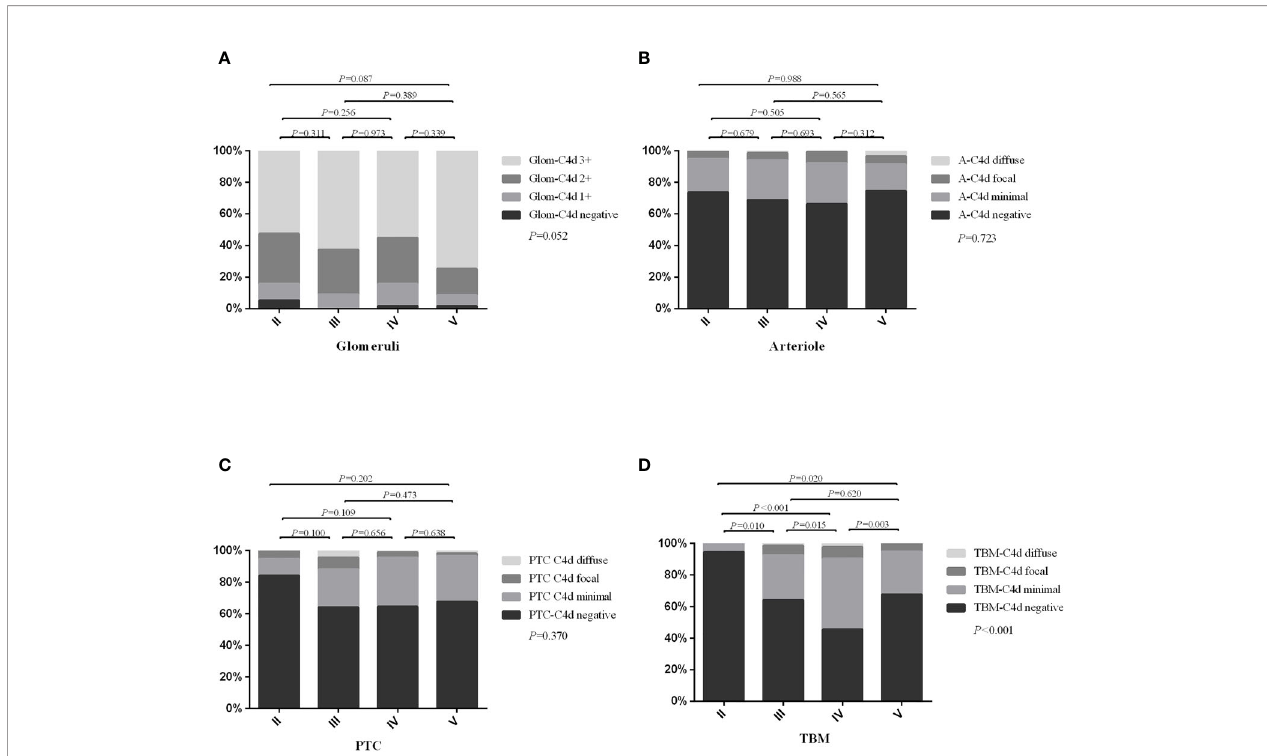
FIGURE 2 | The distribution or intensity of C4d staining between different lupus nephritis sub-classes. (A) showed the intensity of glomerular C4d staining; (B) showed distribution of arteriolar C4d staining; (C) showed distribution of PTC-C4d staining; (D) showed distribution of TBM-C4d staining. Glom, glomerular; A, arteriolar; PTC, peritubular capillary; TBM, tubular basement membrane. Bonferroni ’ s correction for multiple correlations: statistical signi fi cance was considered at P < 0.008 (0.05/6).